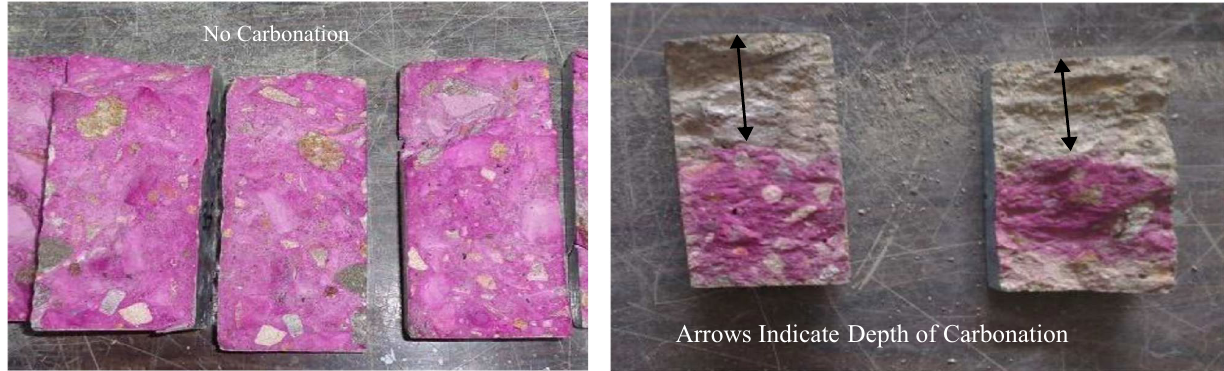
Fig. 22 Rubbercrete Specimens showing the depth of carbonation